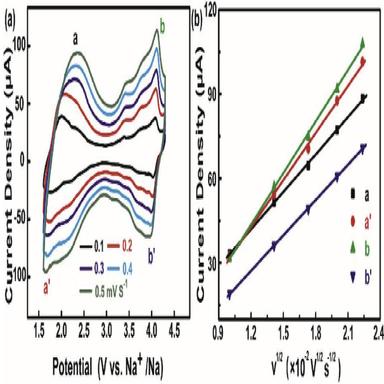
(a) The CV curves at different scan rates (0.1e0.5 mV s1 ); (b) Linear fitting for the relationship between ip and v1/2 from CV profiles. The voltage range is 1.6e4.3 V.